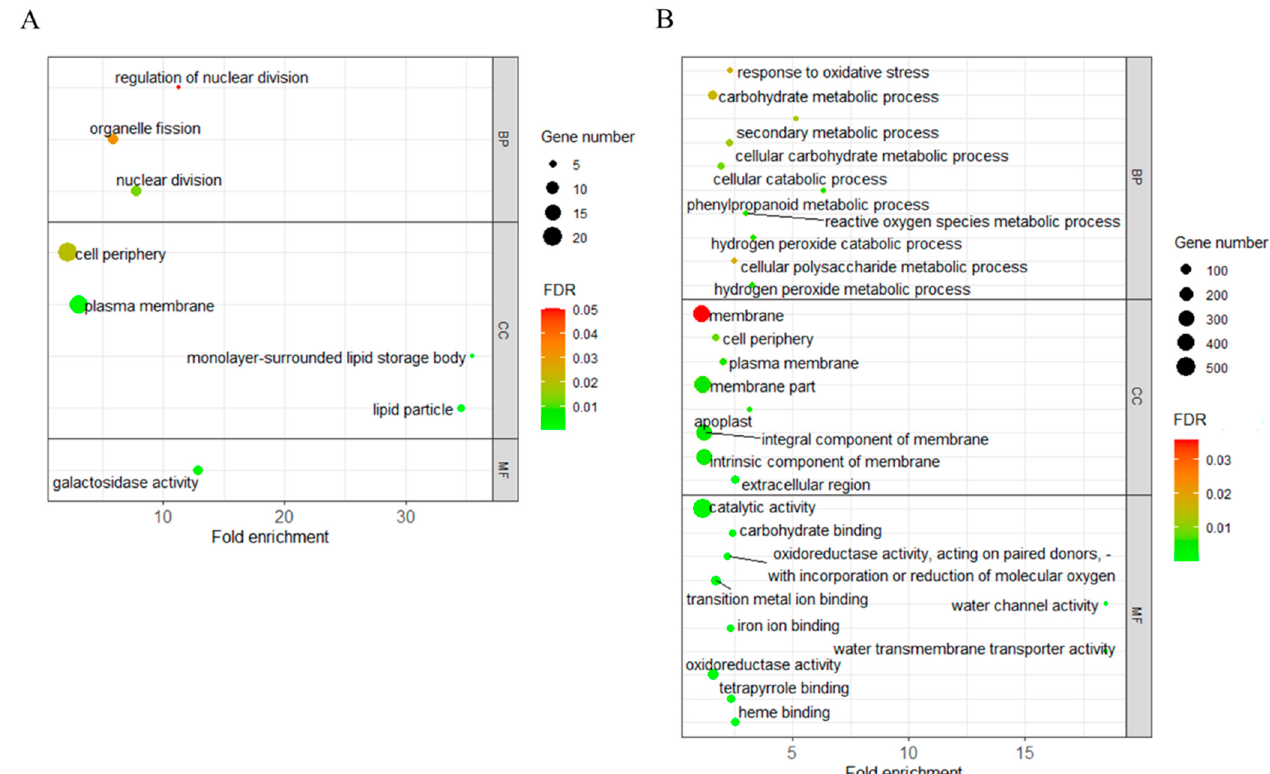
Figure 4. GO enrichment analysis of L220-specifically expressed LTGA genes (DEGs) with up- ( A ) and downregulated ( B ) expression. The size of the dot indicates the number of DEGs involved in the GO category. The color scale indicates the significance level (FDR). The rich factor is the ratio between the number of DEGs and all genes enriched in the category.